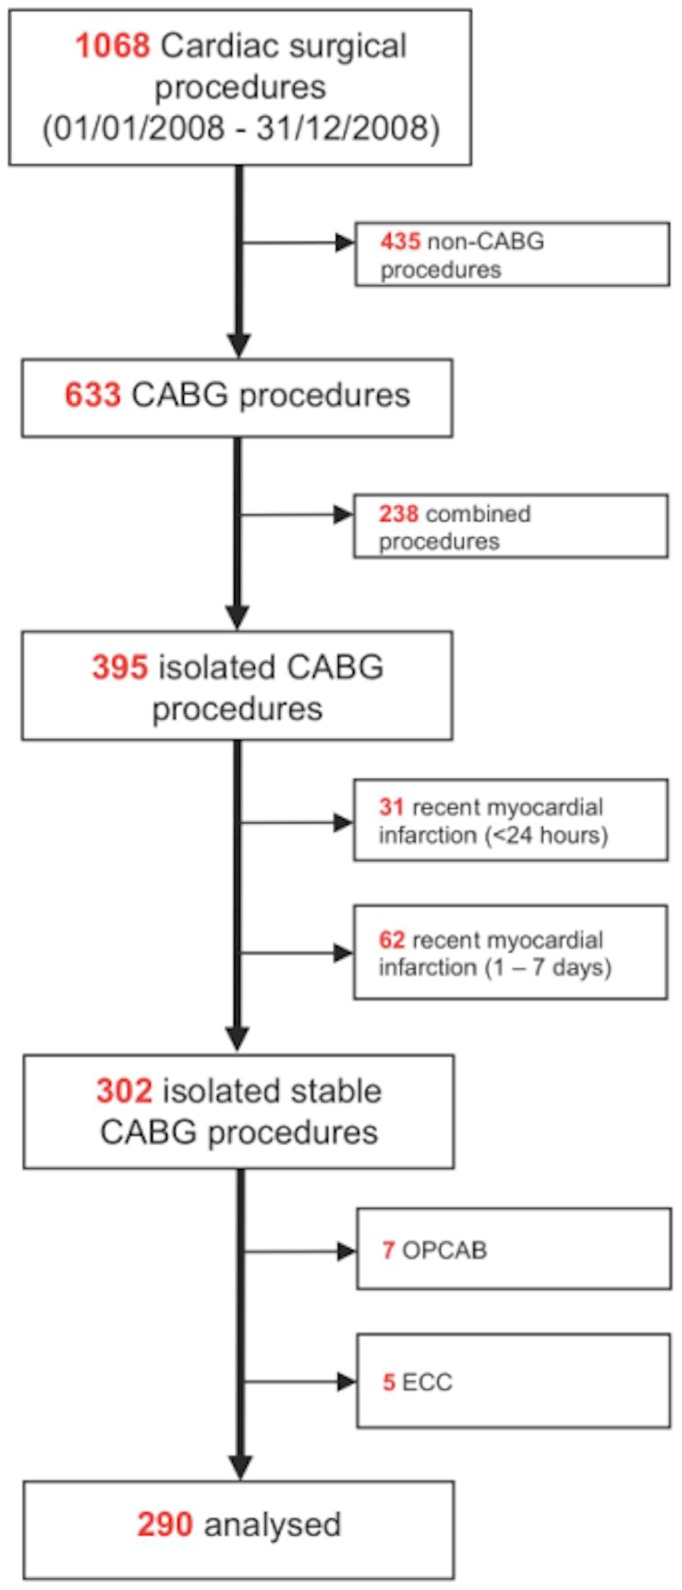
Selection process.